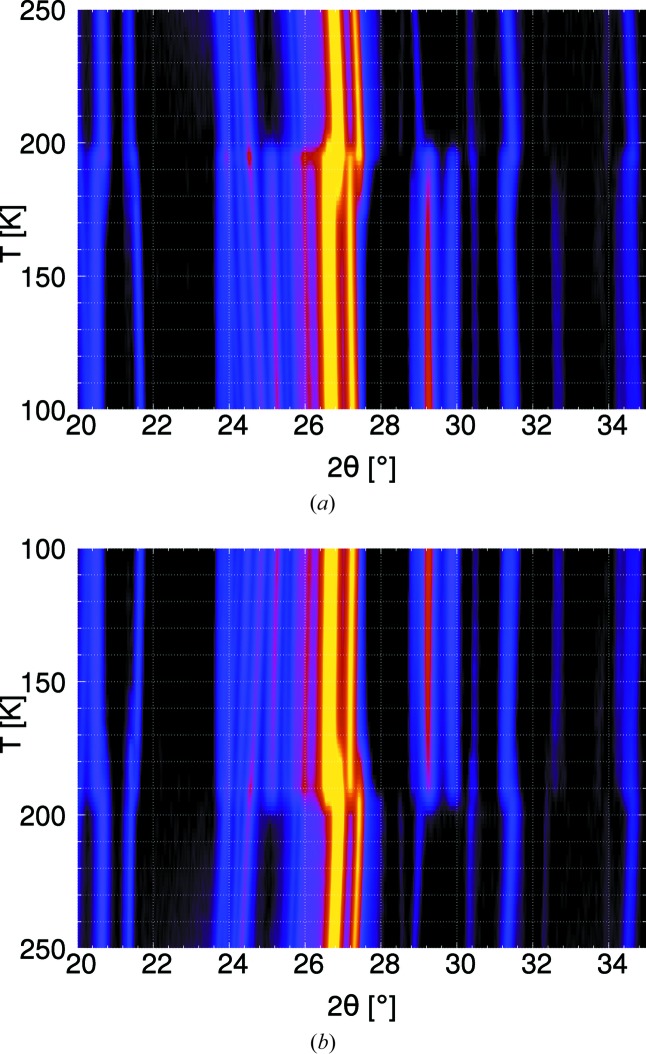
Powder diffraction patterns of 1 (a) on heating and (b) on cooling, taken at 5 K intervals. Scans are arranged in chronological order from bottom to top.